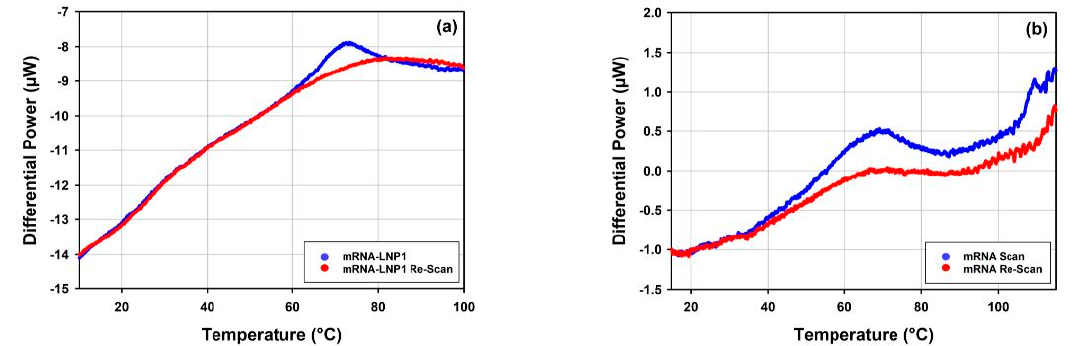
Figure 13. Overlays of the raw DSC data as traces of differential power, DP over temperature for a scan and a re-scan of ( a ) mRNA-LNP1 and ( b ) free mRNA samples.